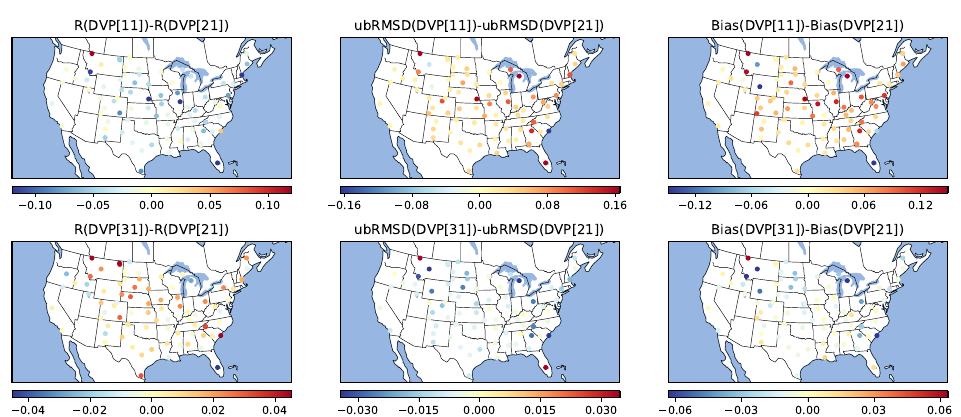
Figure 10. Impact of the kernel half-width ( λ ) on R, ubRMSD and bias between in situ and soil moisture retrieved using dynamic vegetation parameters. Half-widths of λ = 11 and λ = 31 are compared to the default value of λ = 21 in the top and bottom rows, respectively